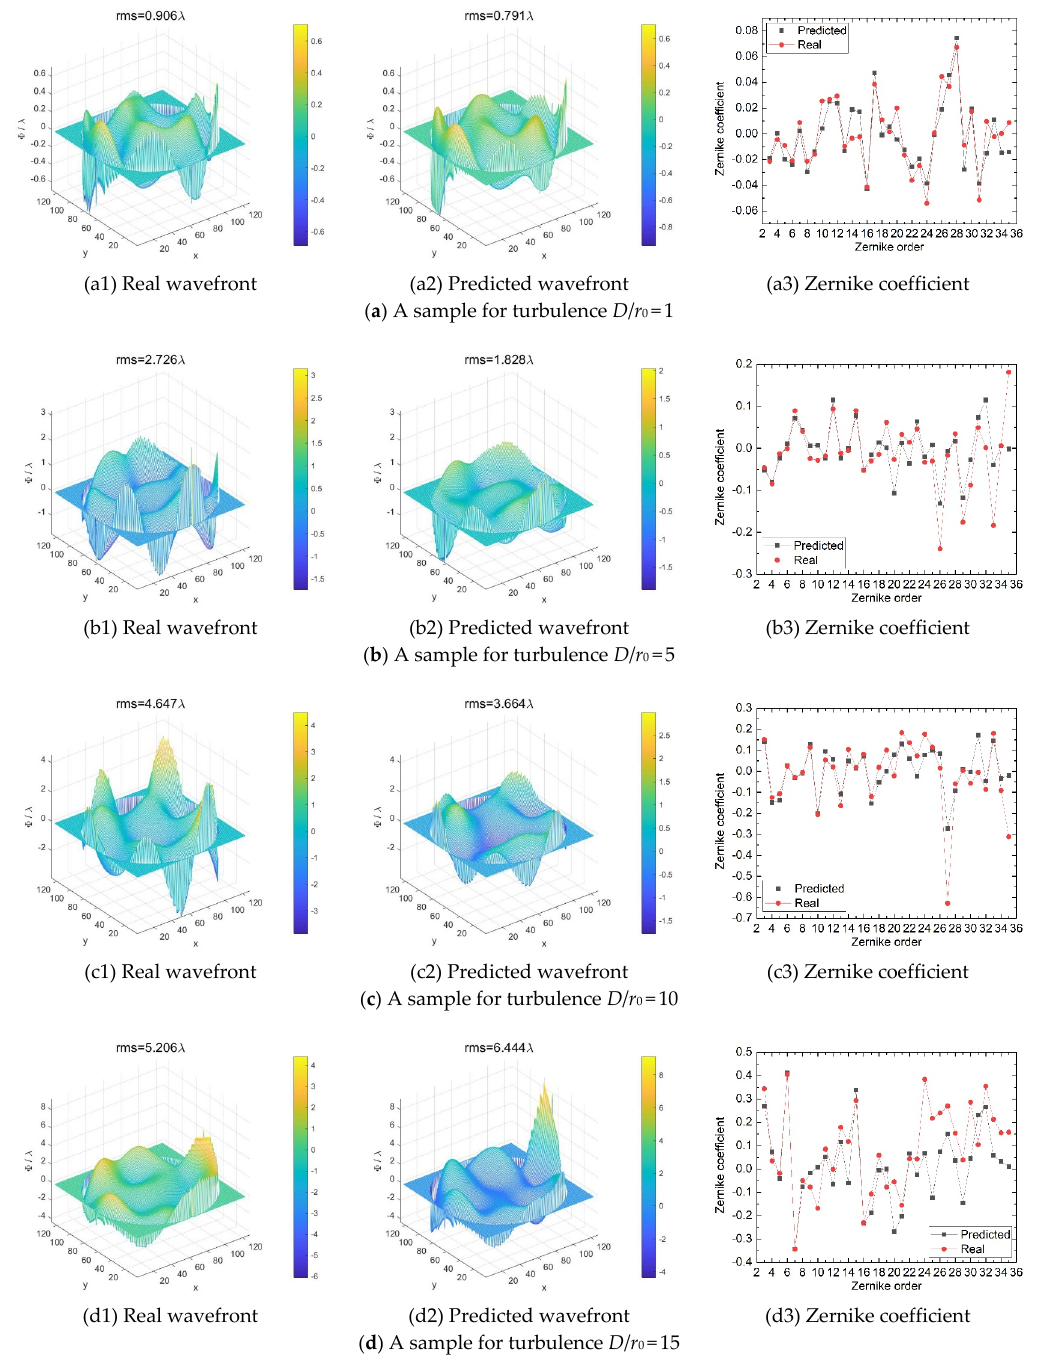
Figure 5. Four turbulence aberration samples for ( a ) D / r 0 = 1, ( b ) D / r 0 = 5, ( c ) D / r 0 = 10, ( d ) D / r 0 = 15: the first column is the real wavefront, the second column is the predicted wavefront by GoogLeNet S3 and the third column is the comparison of Zernike coefficients between the real wavefront and the predicted